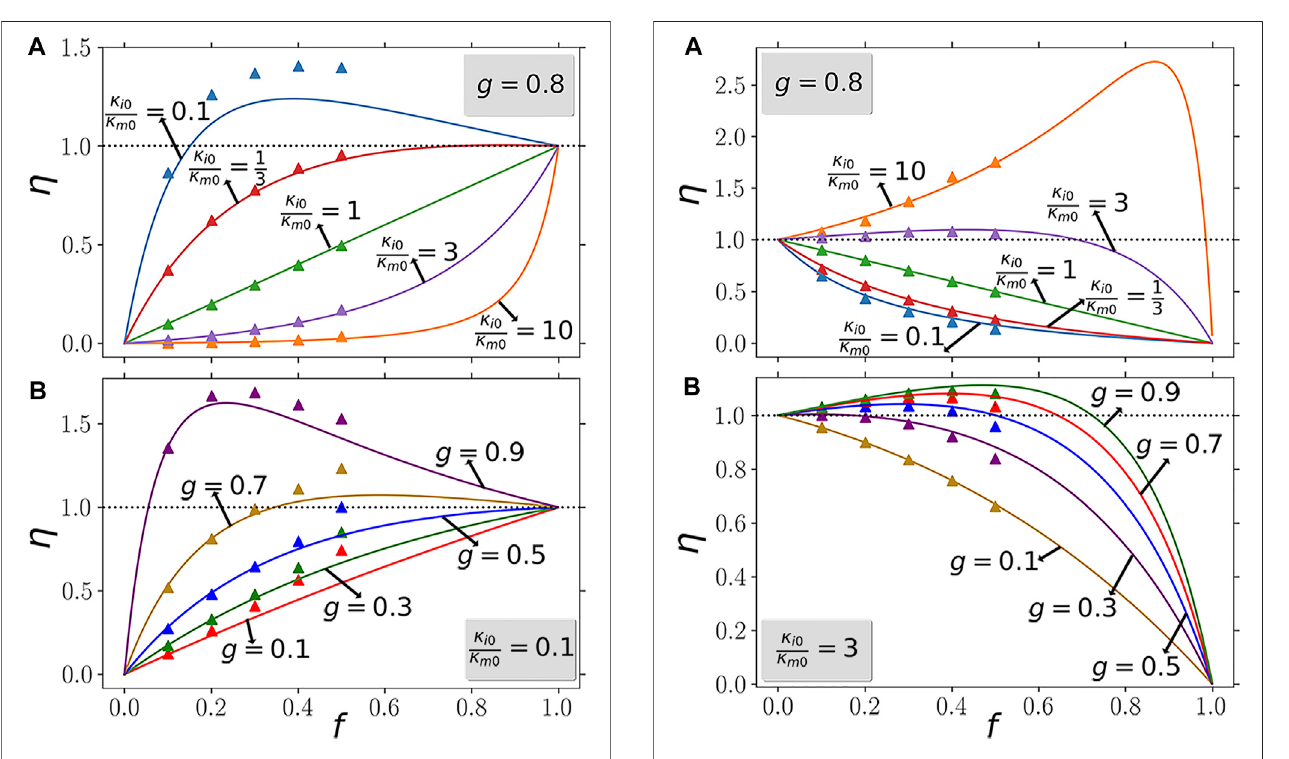
FIGURE 4 | How η varies with f for nonlinear inclusions and linear matrix. The scatter plots represent the numerical results for f = 0.1, 0.2, 0.3, 0.4, and 0.5, while the solid lines show the theoretical values. (A) g is 0.8 while κ i 0 / κ m 0 takes different values. (B) κ i 0 / κ m 0 is 0.1 while g takes different values.